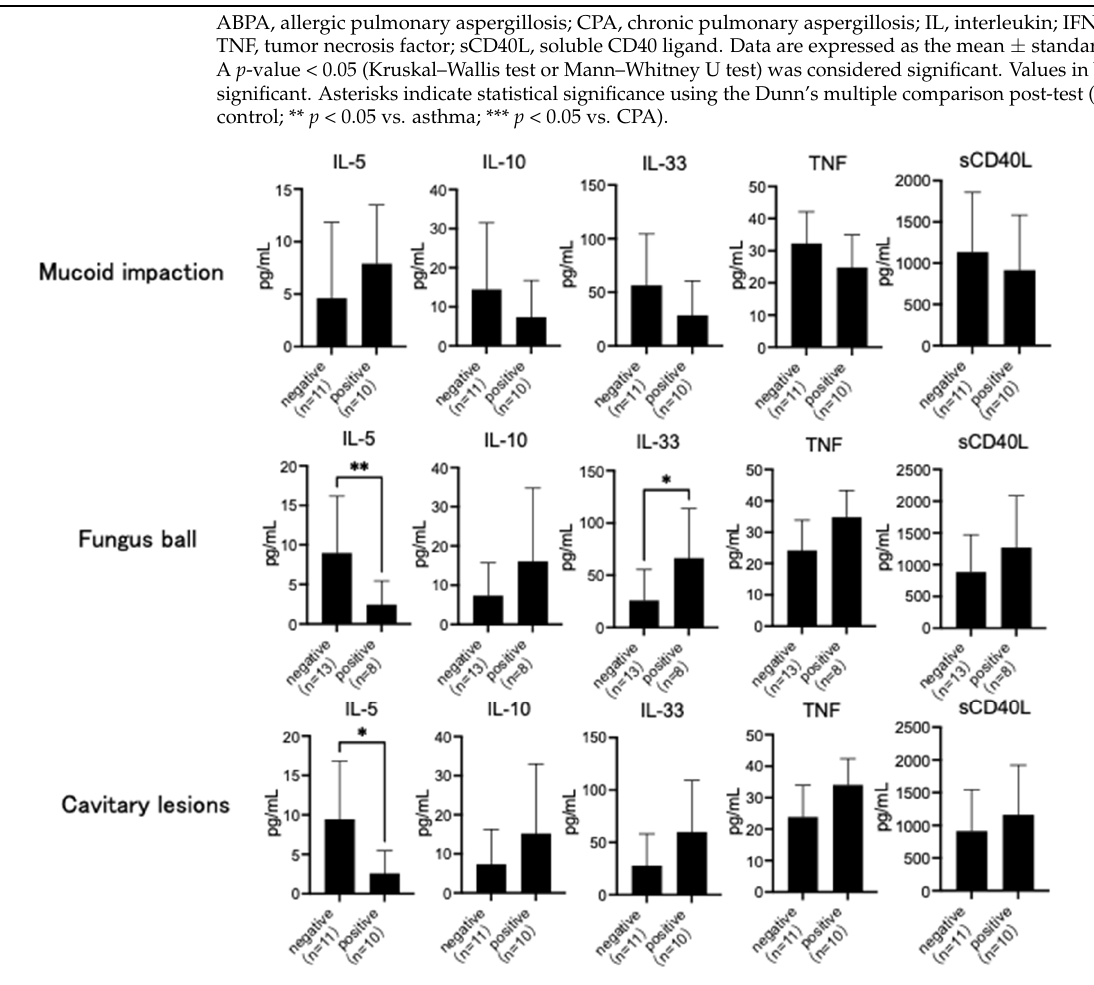
Figure 1. Chest computed tomography (CT) findings and serum cytokine. Interleukin (IL)-5 levels were high in subjects with mucoid impaction and significantly lower in those with fungus ball and cavitary lesions on chest CT. IL-10, IL-33, tumor necrosis factor (TNF), and soluble CD40 ligand (sCD40L) levels were low in subjects with mucoid impaction and high in those with cavitary lesions on chest CT. IL-33 level was significantly higher in subjects with fungus balls. Data are expressed as the mean ± standard deviation. Error bars indicate standard deviation. Statistical analyses were performed using the Mann–Whitney U test. Asterisks indicate statistically significant differences (* p < 0.05; ** p < 0.01).